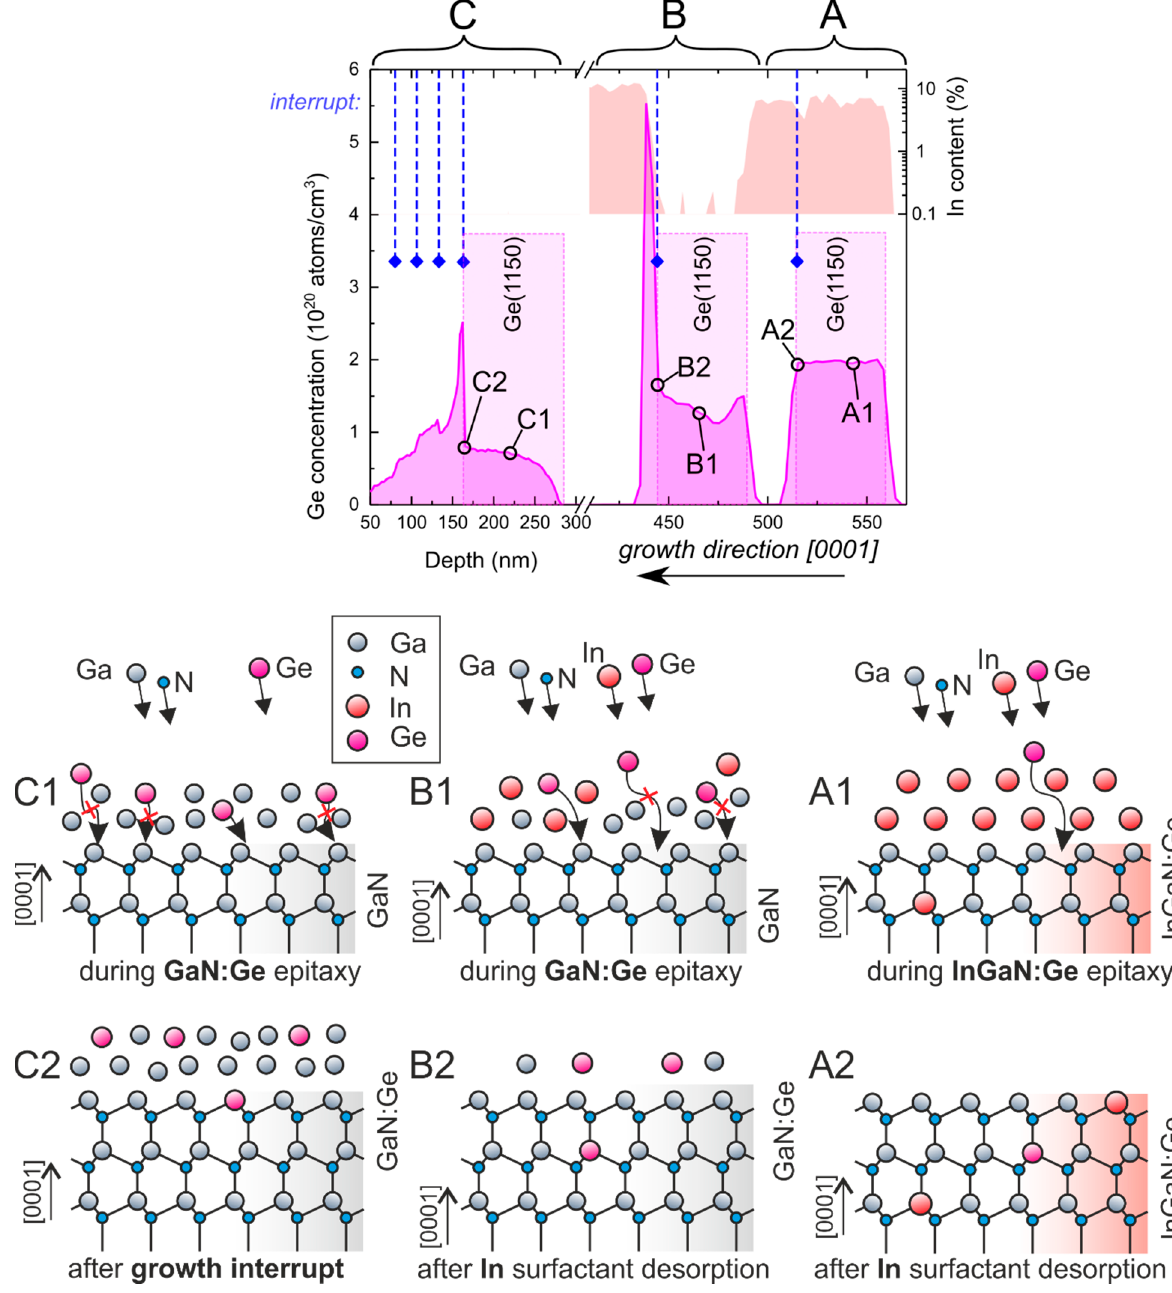
Figure 2. Germanium concentration measured by SIMS (linear scale) as a function of depth for a stack of InGaN:Ge and GaN:Ge layers separated by intentionally undoped layers. Indium content as a function of depth is shown on the right-hand side axis. Places where germanium effusion cell was opened are marked by additional shading with germanium cell temperature in Celsius (which was kept constant in this experiment). Places where all atomic fluxes were closed to allow for excess gallium and indium desorption are marked with dashed blue lines and a diamond symbol. Parts ( A – C ) show distinct parts of the doping profile obtained on a single sample. Cartoons on the bottom part schematically depict state of the surface at points A1, A2, B1, B2, C1 and C2 as marked in the doping